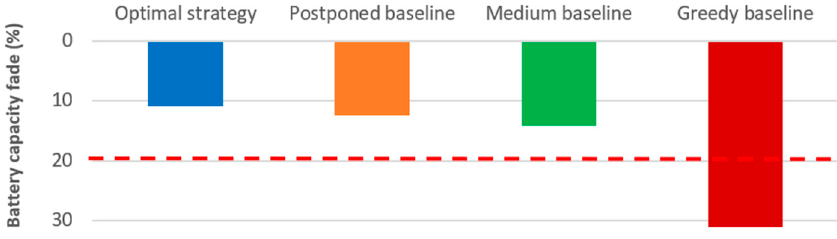
Figure 10. Battery capacity loss during 10 years of operation.